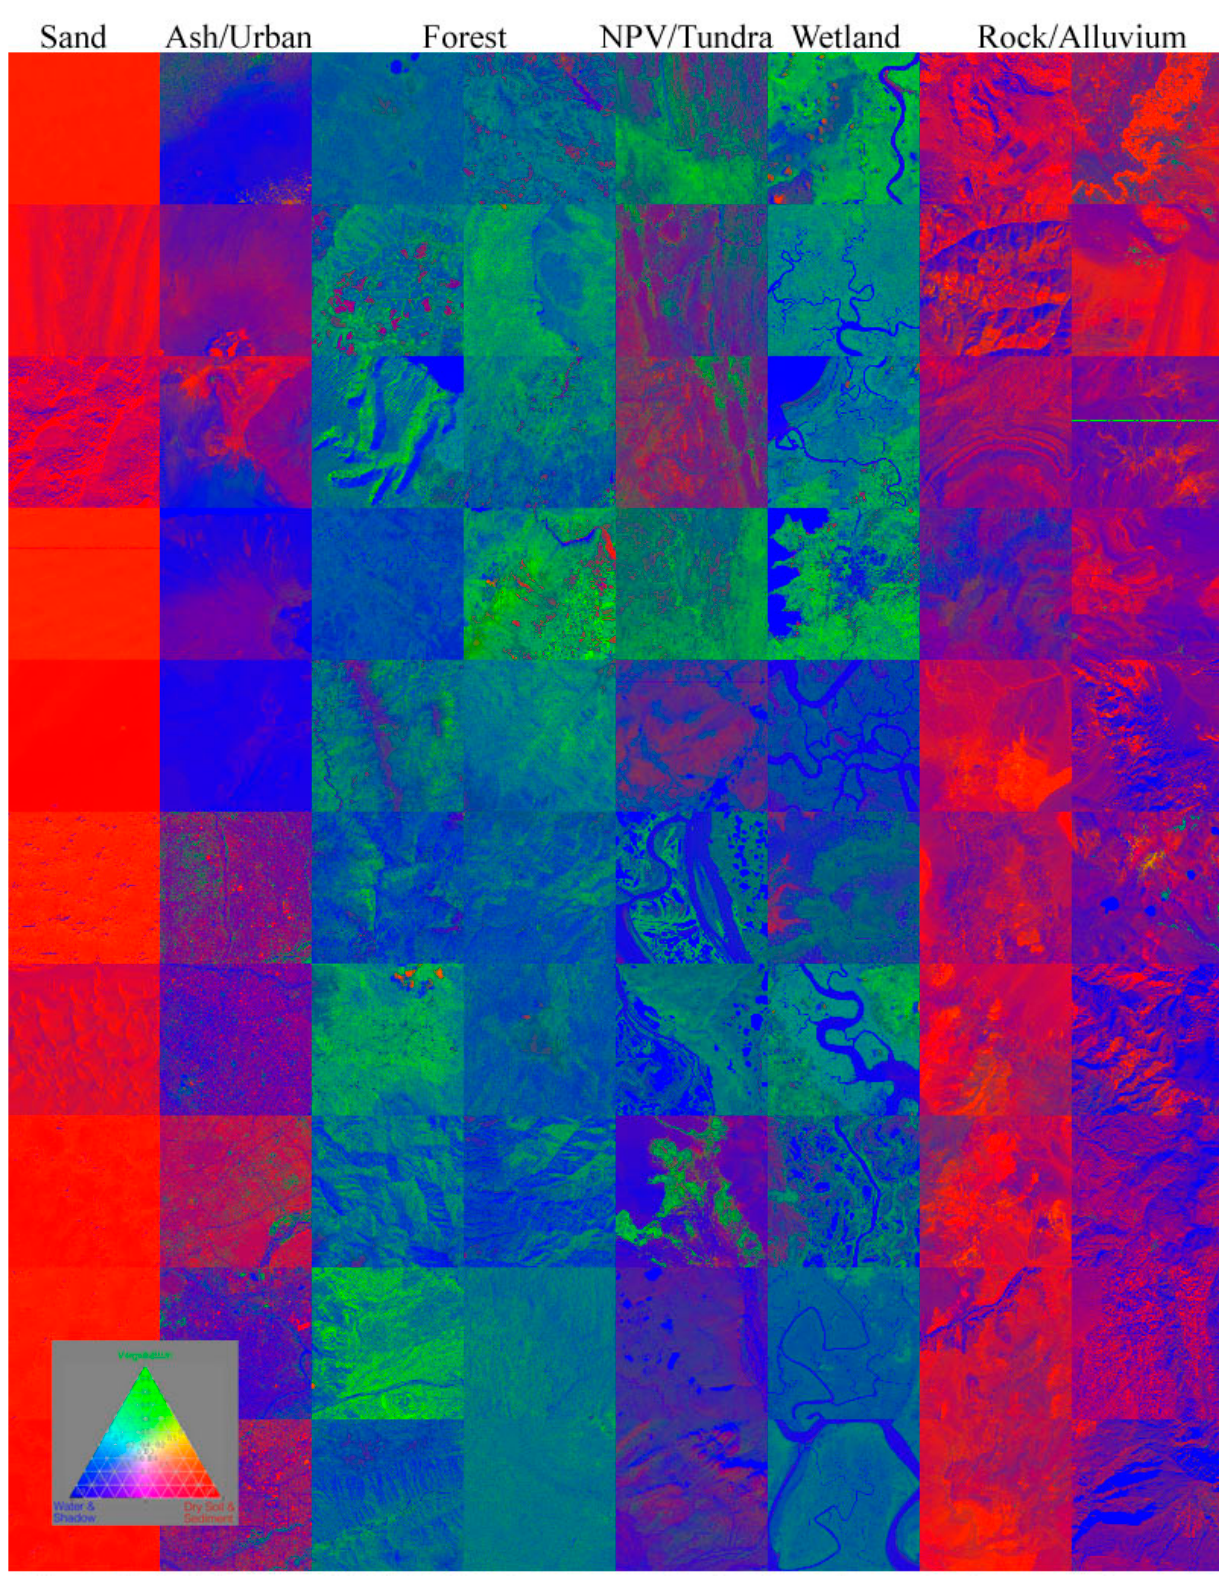
Figure 7. Minimal model SVD fraction mosaic for the primary land cover subset. Linear stretch [0,1] for all fractions. Sands are saturated red because they are outside the minimal model with S I fractions >1.